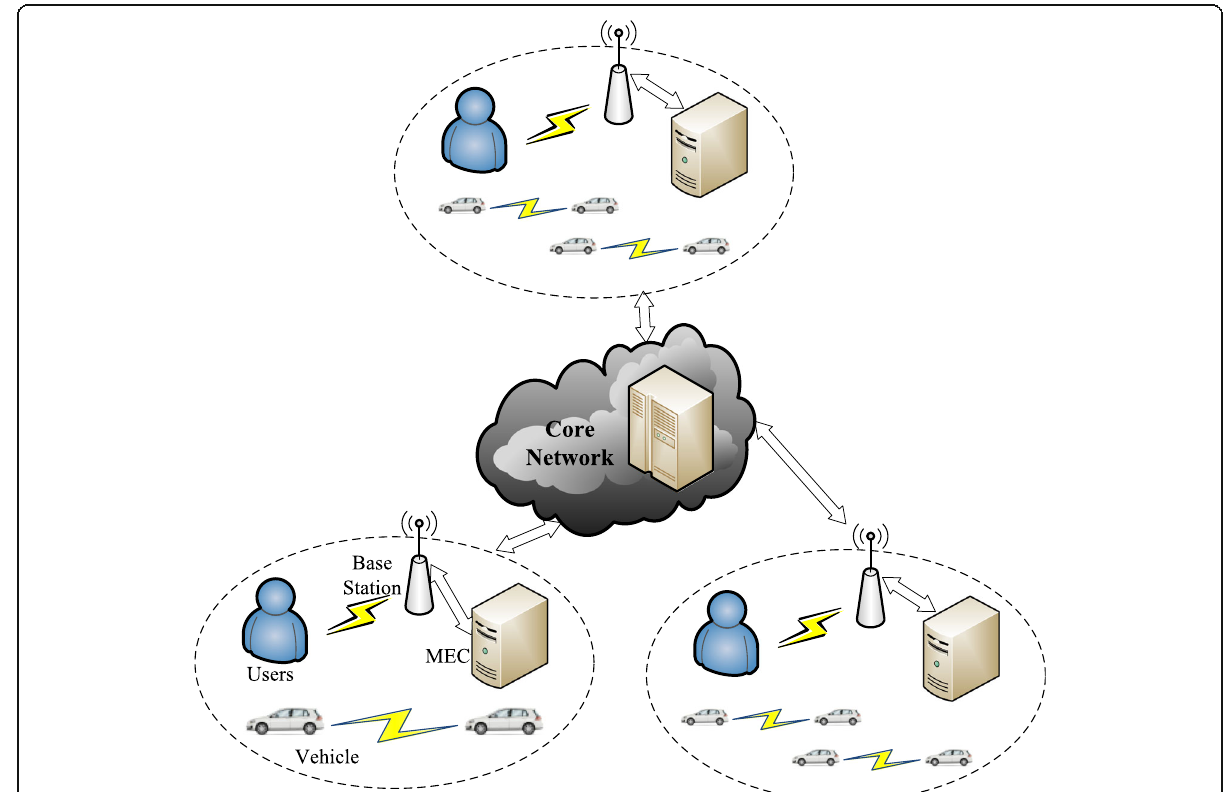
Fig. 1 System model of multi-area multi MEC